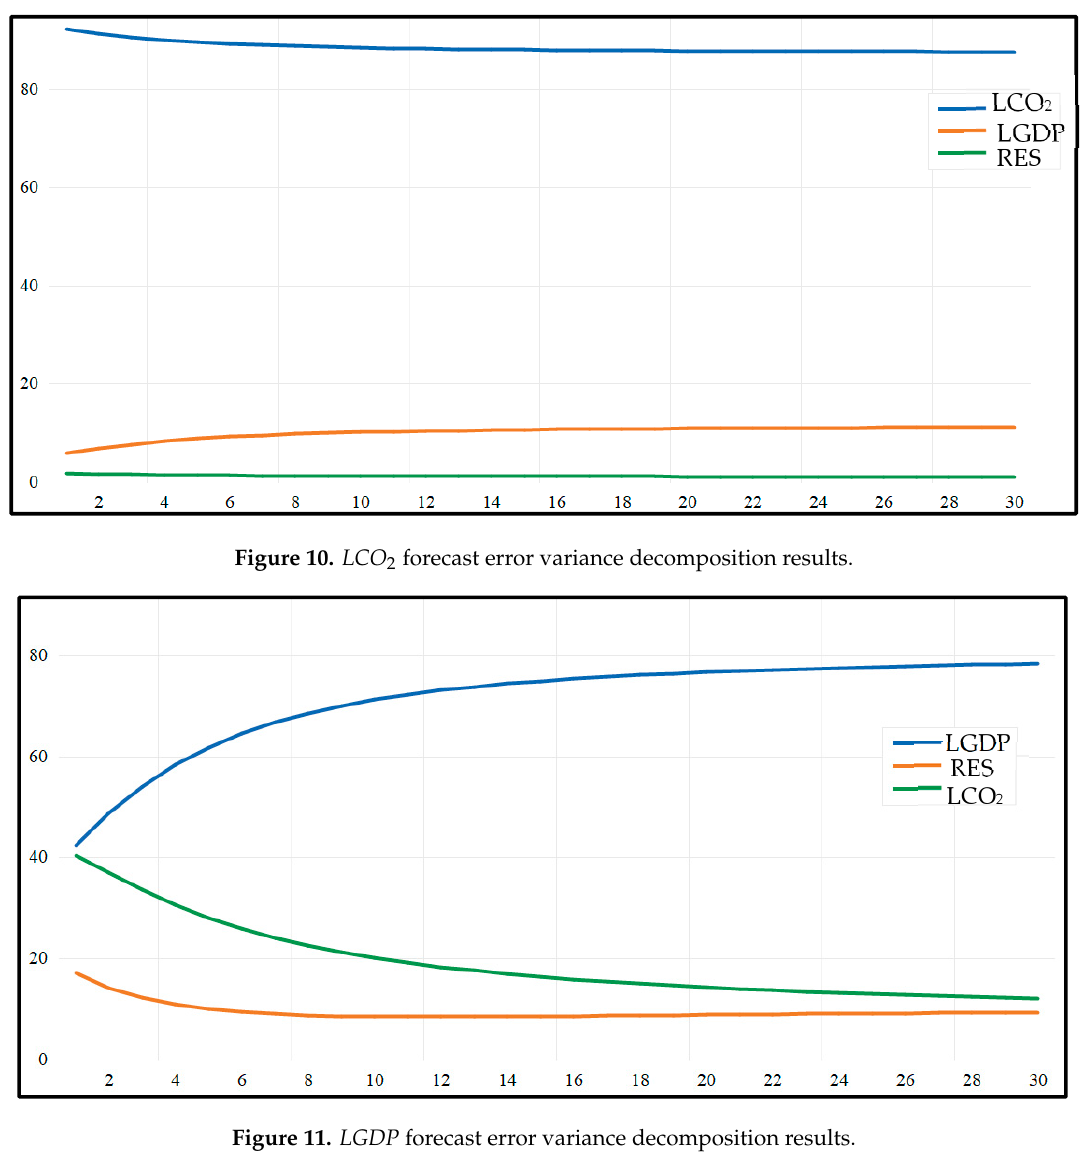
Figure 11. LGDP forecast error variance decomposition results.